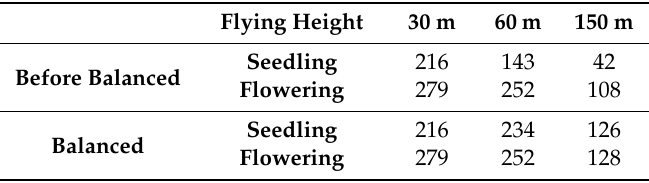
Table 1. Image quantities before and after